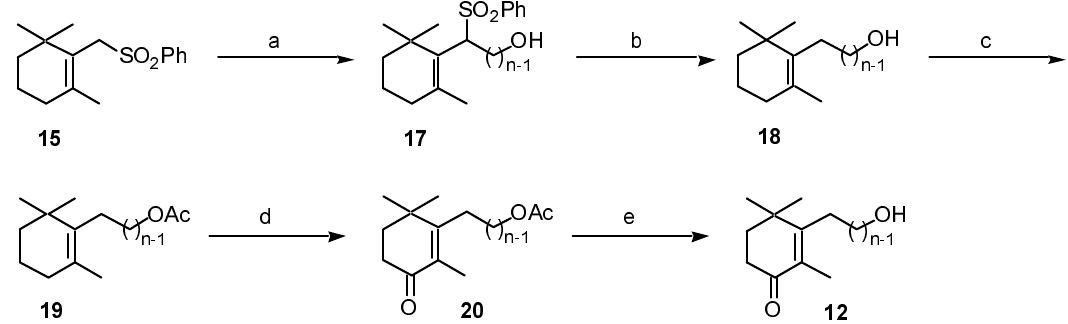
Figure 7. Synthesis of t-CFAs ( 12 ) from sulfone 15 . Reagents: (a) n-BuLi, THF, HMPA, CHPh 78°C to r.t., 1 hour; Br(CH Na HPO , 0°C to r.t., 3 hours (88-93%). (c) Ac 2 4 mol, tBuOOH 70%, cyclohexane, H (81-96%).